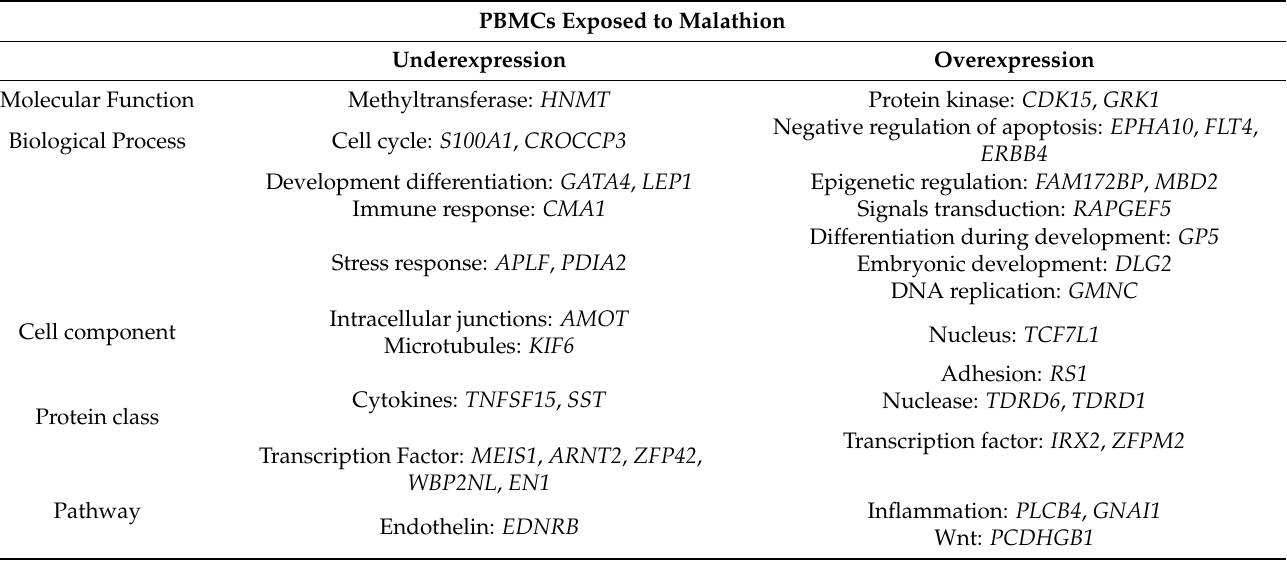
Table 2. Highlights of gene ontology analysis of the top and bottom 100 genes with over and underexpression in PBMCs exposed to malathion.